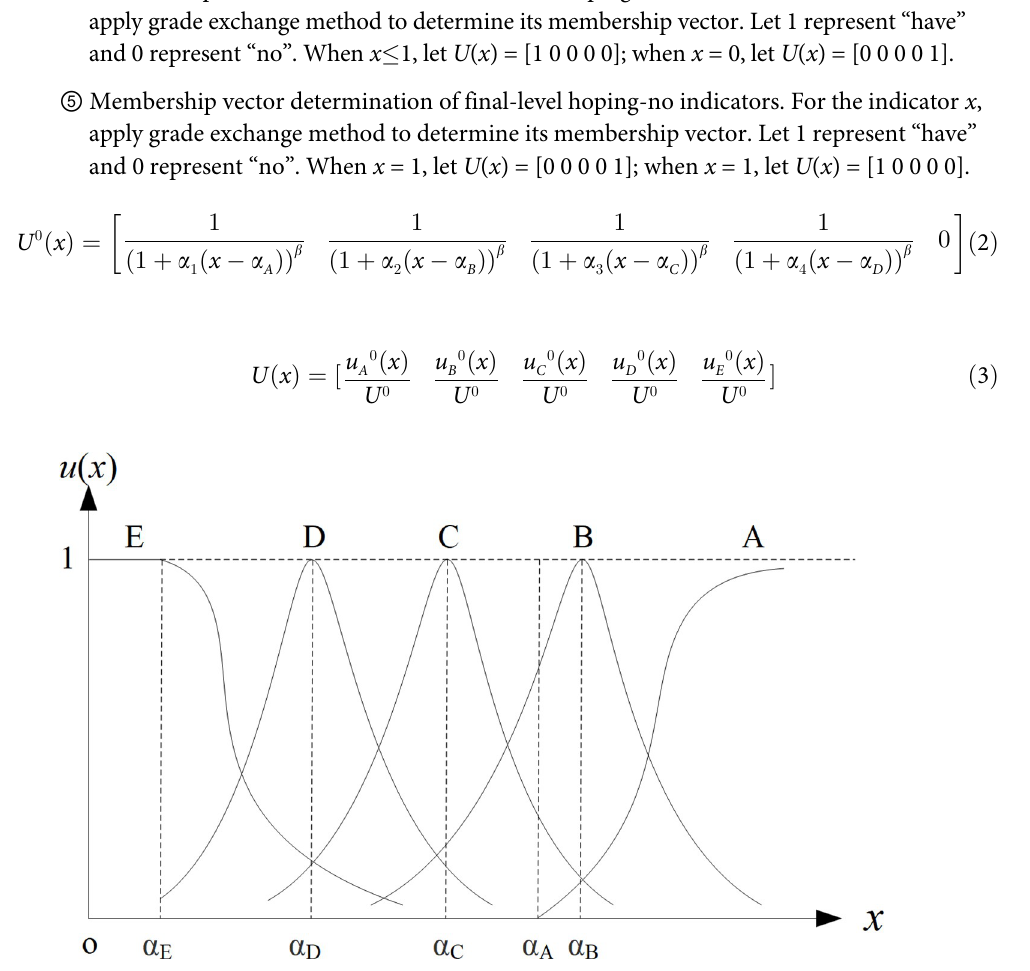
Fig 2. Membership vector of final-level hoping-large